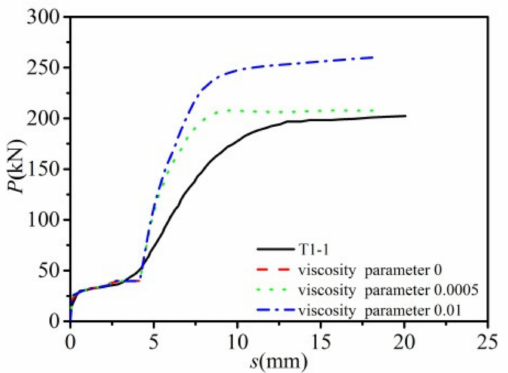
Figure 7. Effect of viscosity parameter on load-slip relationship of T1-1 specimens.